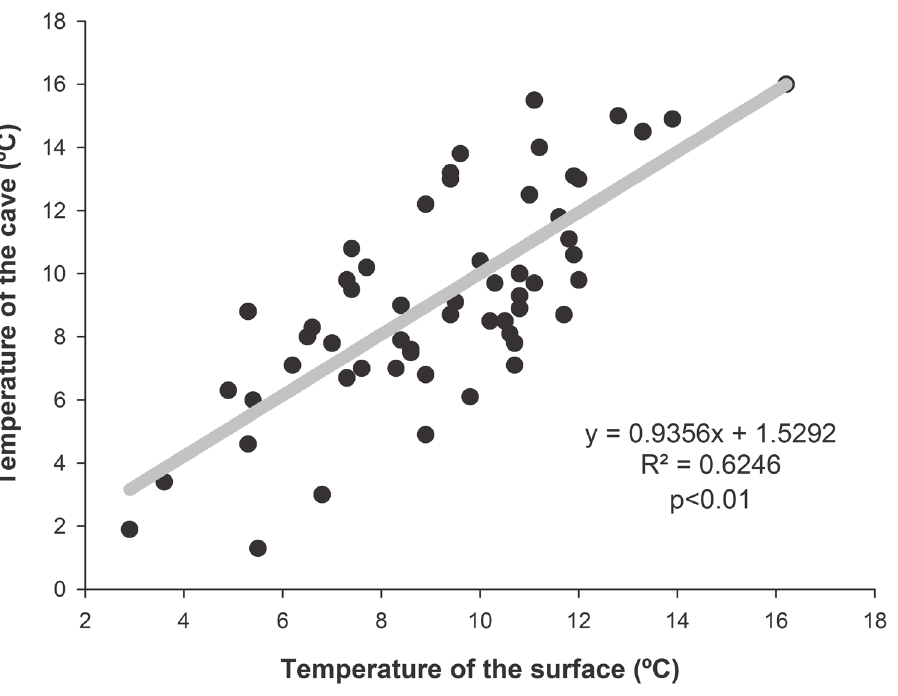
Figure 1. Relationship between the temperature inside the cave and the surface (Mean Annual Temperature (°C) of each pixel (0.08°